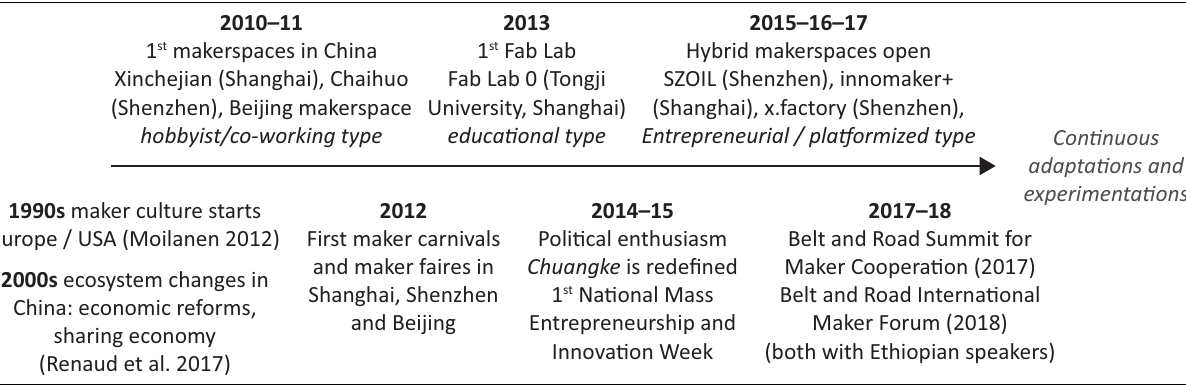
Figure 1. Makers in China timeline. Source: Bolli